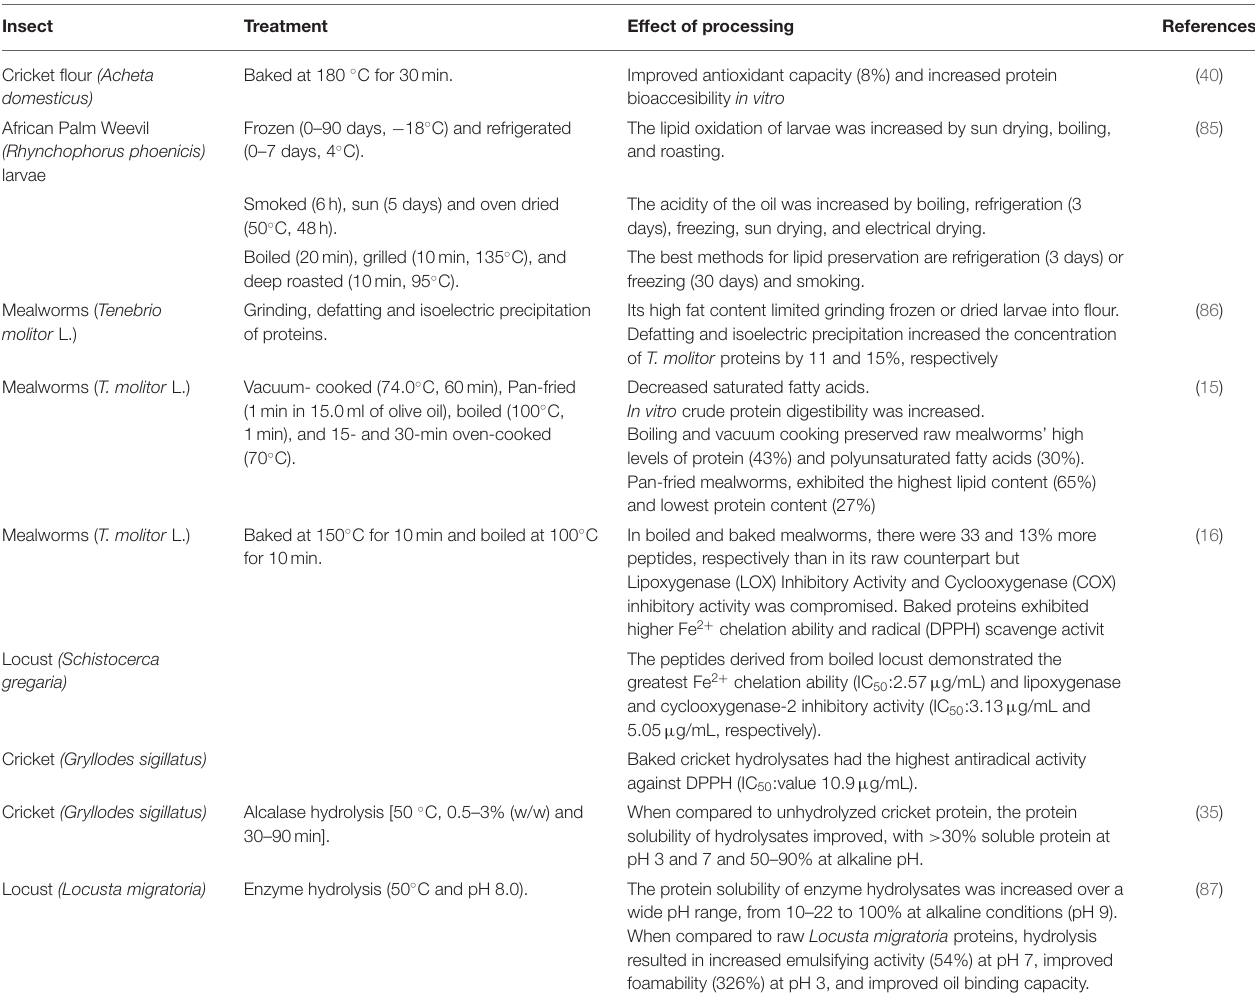
TABLE 3 | Effect of processing insects on their different